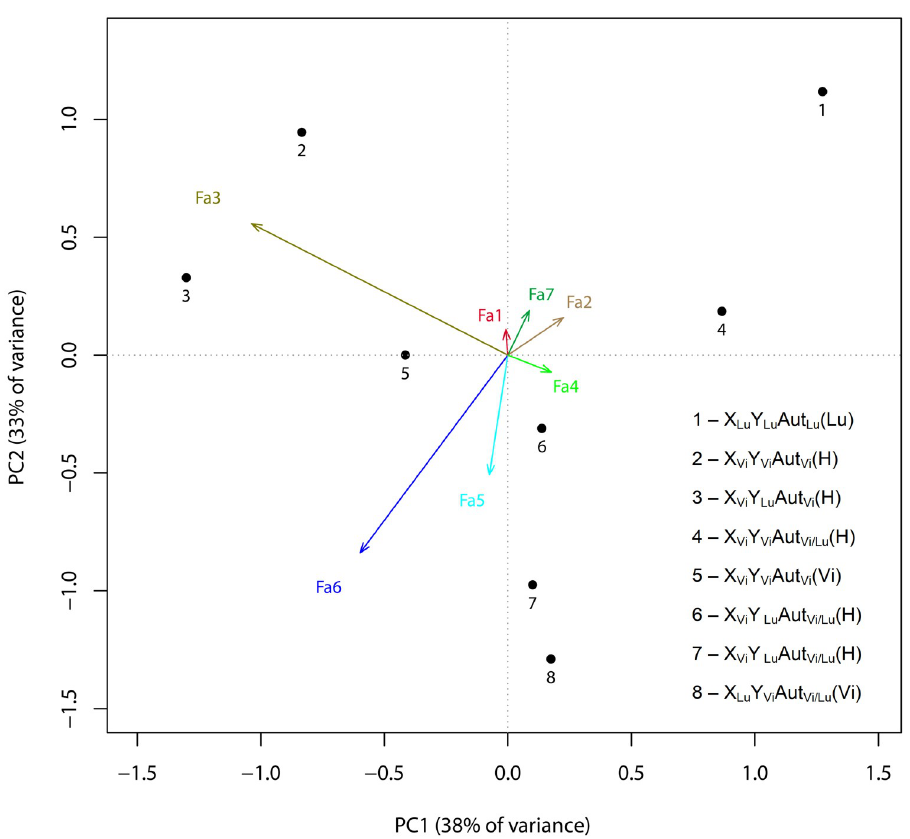
Fig 4. Redundancy analysis: Association of factor structure values and genotypes. Numbers denote particular genotypes: 1, X Lu Y Lu Aut Lu Lu (parent male was a D . lummei male); 2, X Vi Y Vi Aut Vi Vi/Lu (parent male was a hybrid F1 male with a set of X Vi Y Lu sex chromosomes or with the opposite set of sex chromosomes, X Lu Y Vi ); 3, X Vi Y Lu Aut Vi Vi/ Lu (parent male was a hybrid F1 male with a set of X Vi Y Lu sex chromosomes or with the opposite set of sex chromosomes, X Lu Y Vi ); 4, X Vi Y Vi Aut Vi/Lu Vi/Lu (parent male was a hybrid F1 male with a set of X Vi Y Lu sex chromosomes or with the opposite set of sex chromosomes, X Lu Y Vi ); 5, X Vi Y Vi Aut Vi Vi (parent male was a D . virilis male); 6, X Vi Y Lu Aut Vi/Lu Vi/Lu (parent male was a hybrid F1 male with a set of X Vi Y Lu sex chromosomes or with the opposite set of sex chromosomes, X Lu Y Vi ); 7, X Vi Y Lu Aut Vi/Lu Lu (parent male was a D . lummei male); 8, X Lu Y Vi Aut Vi/ Lu Vi (parent male was a D . virilis